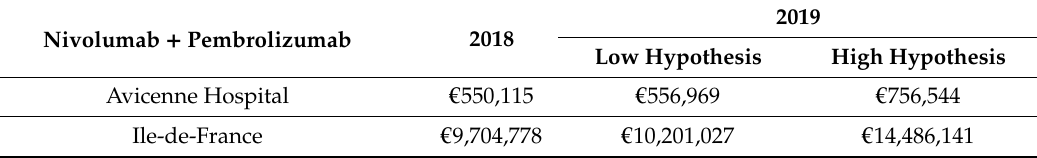
Table 7. Global annual additional cost for the two molecules for the analyzed